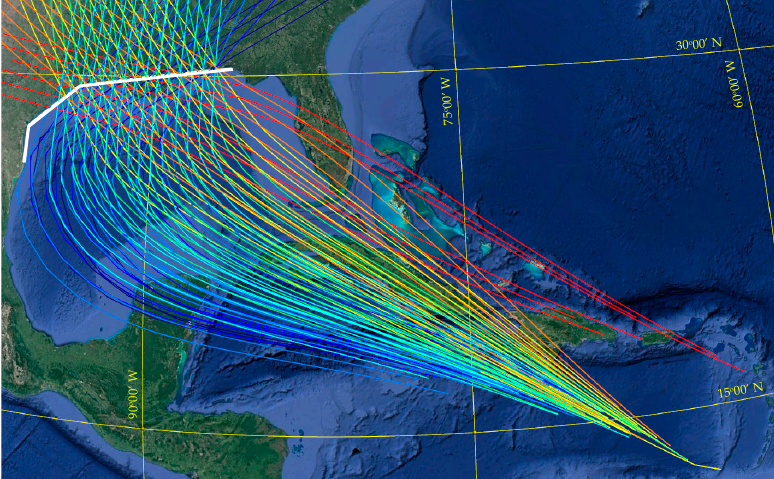
Figure 1. All the master tracks for the considered database, along with the linearized coastal boundary (white line) for the reference landfall definition.